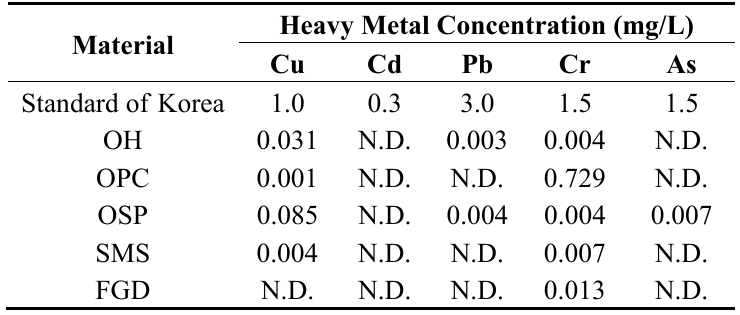
Table 3. Results of heavy metal concentration